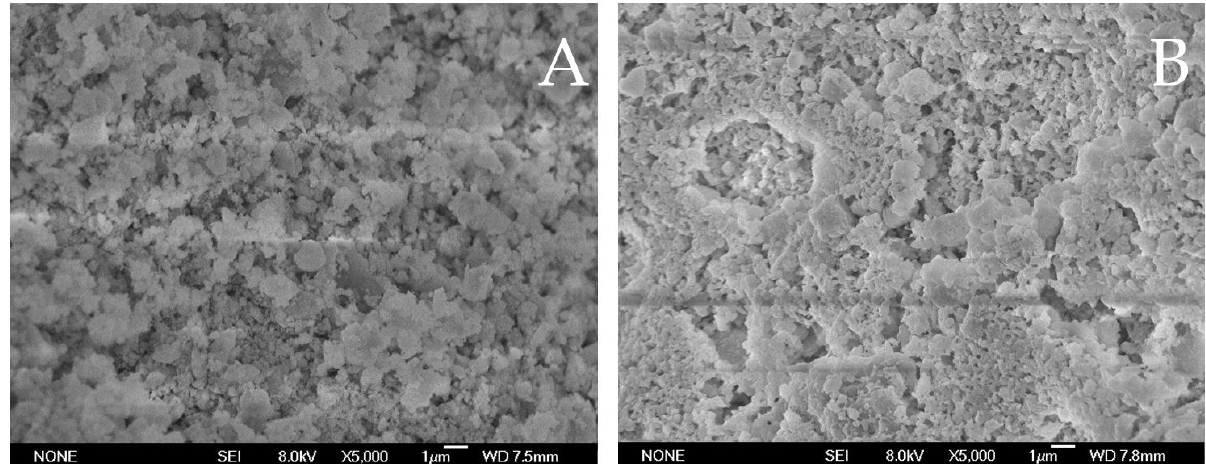
Figure 6. SEM images of the outer surface of the char residue ( A : EFMgO; B : ELDH-1).